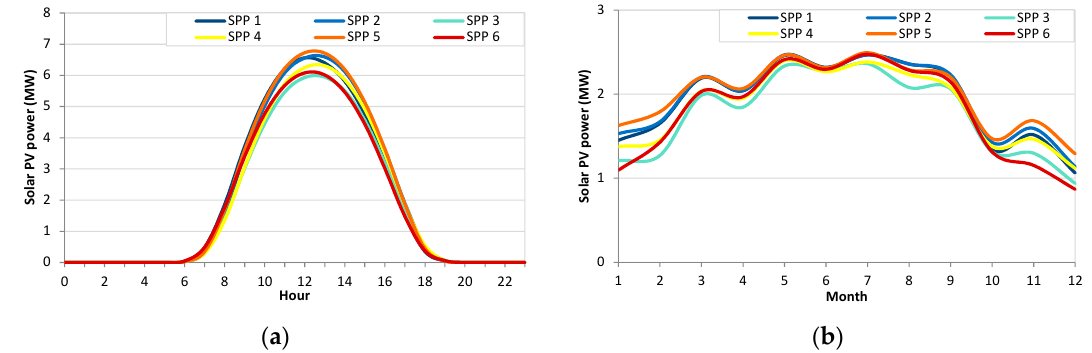
Figure 7. Average ( a ) daily and ( b ) monthly solar PV power profiles for all SPPs identified with the clustering approach.